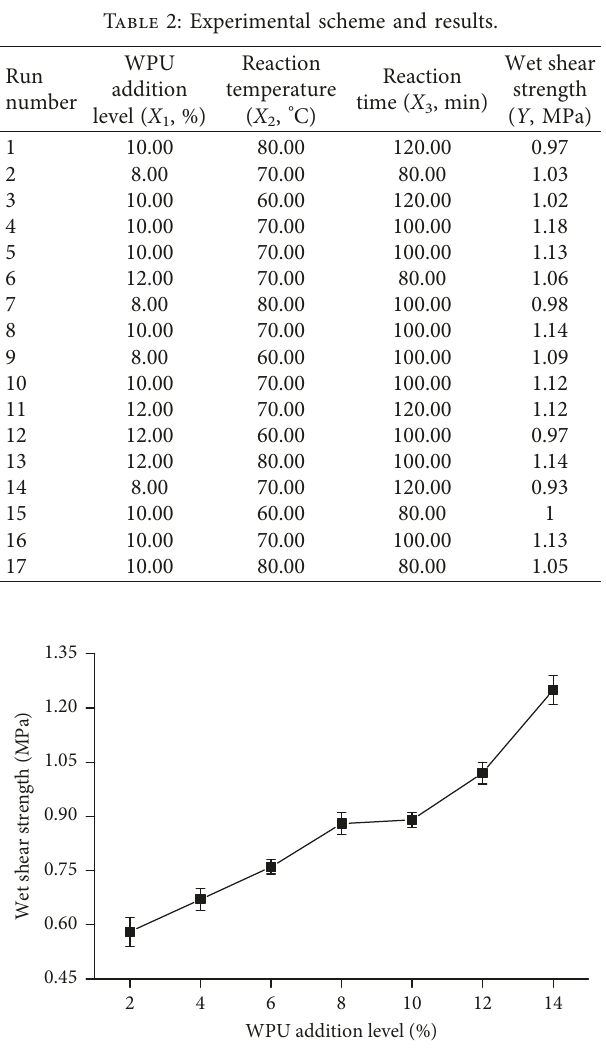
Figure 2: Effects of WPU addition level on wet shear strength.